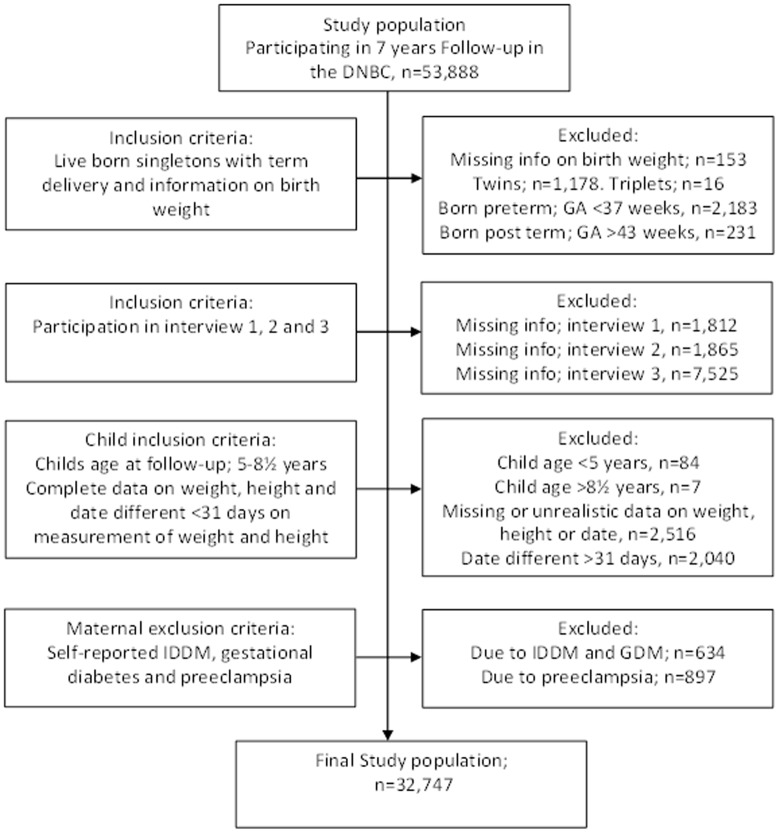
The figure show a flow chart of the study population.